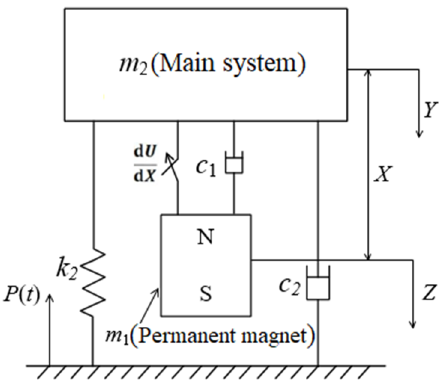
Figure 2. Mechanical model of the main system.